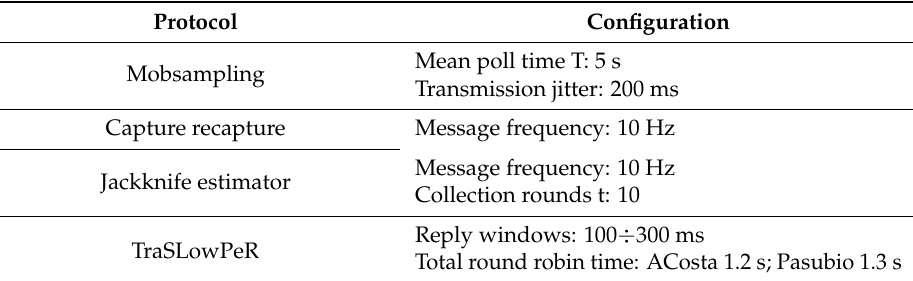
Table 1. Configuration parameters of the 4 compared